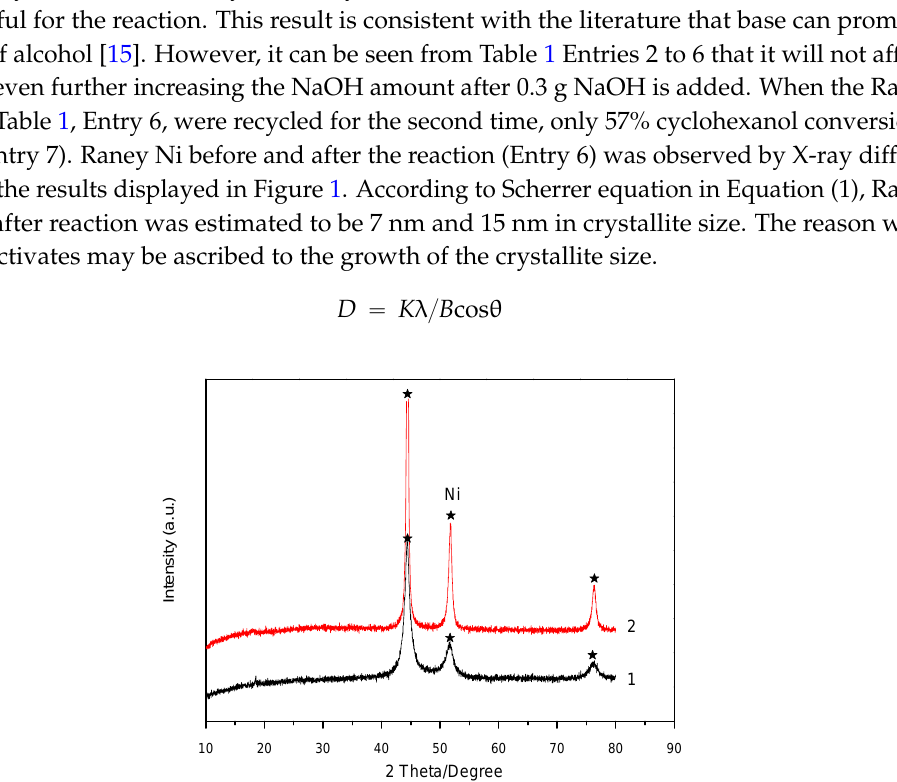
Table 2. Conversion of cyclohexanol into cyclohexylamine over Raney Ni with different time. Entry